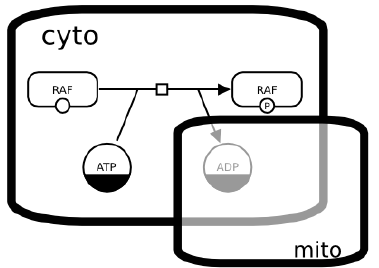
Figure 2.21: Example of an incorrect map. Overlapped compartments must not obscure other